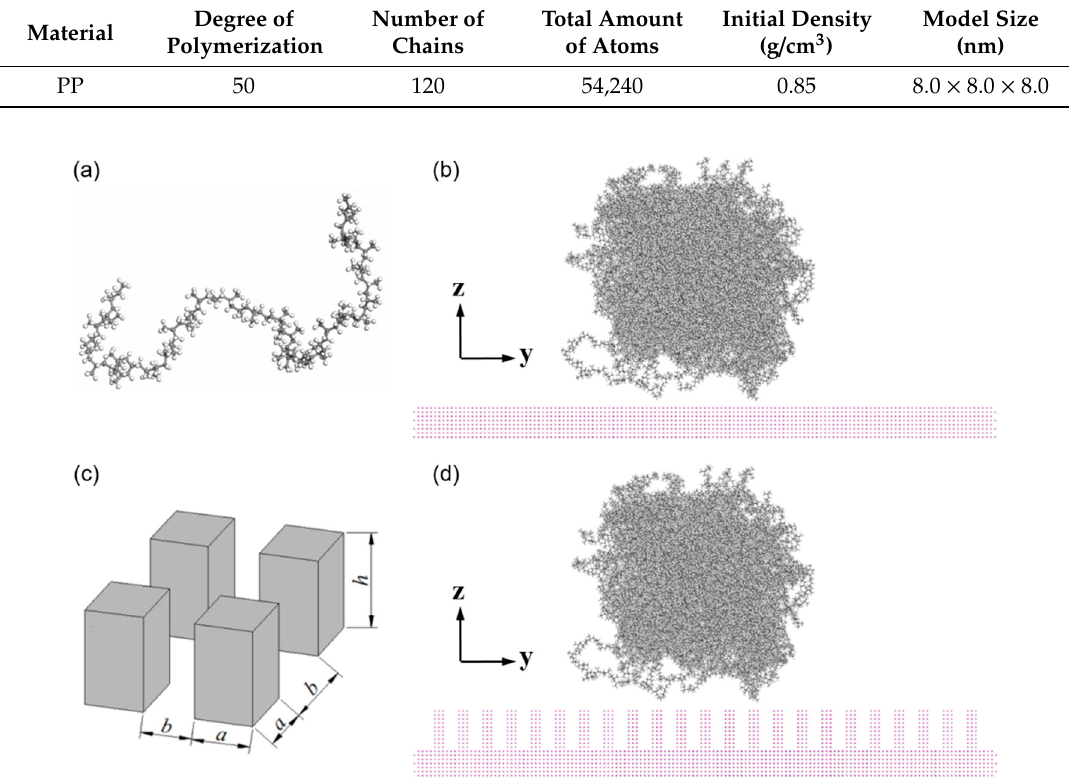
Figure 1. Atomistic models for wetting behavior of PP droplet on the metallic substrate. ( a ) a single chain with the degree of polymerization of 50, ( b ) PP model on the metal substrate with smooth surface, ( c ) nano-column arrays on metal surface and ( d ) PP model on the metal substrate with nano-column arrays.